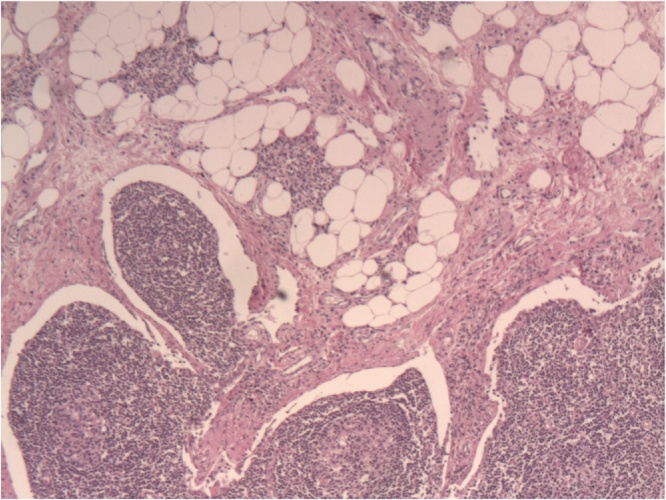
Gentle excision of the mediastinal adenoma from the thoracic cavity (a: parathyroid adenoma).